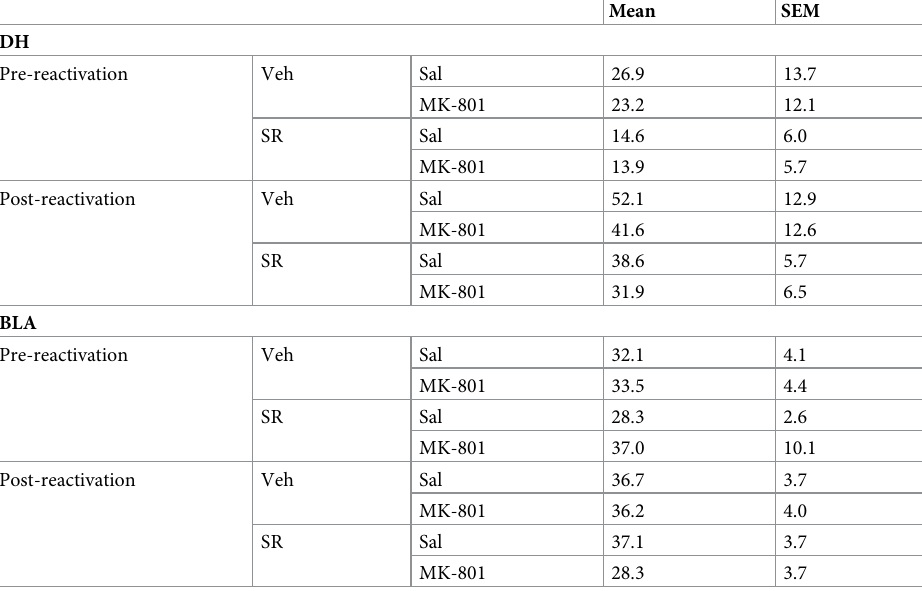
Table 3. Contextual freezing at the reactivation